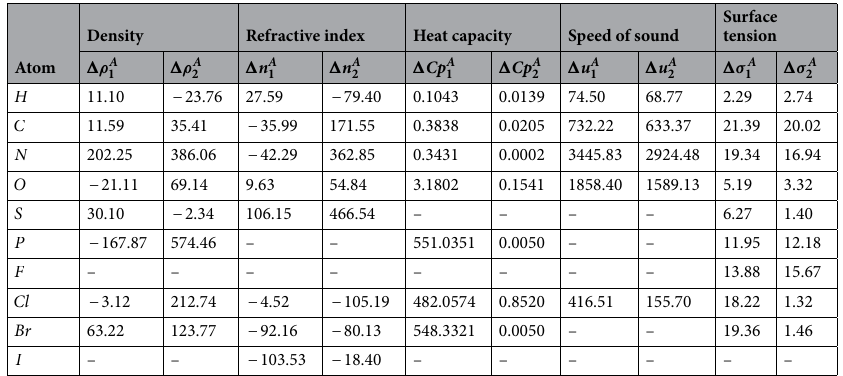
Table 3. The list of functional groups and their contributions for the AC models for density, refractive index, heat capacity, speed of sound and surface